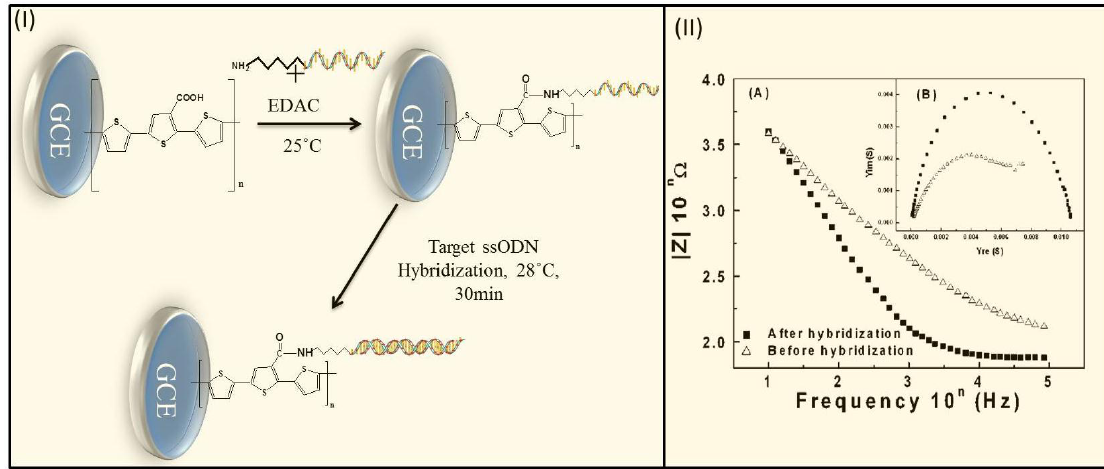
Figure 3. Schematic representation of the immobilization of probe DNA and the hybridization of a target sequence ( I ), and plots of (A) impedance and (B) admittance before and after hybridization in a phosphate buffer solution ( II ). (Redrawn and reproduced with permission from [146]. Copyright 2014, American Chemical